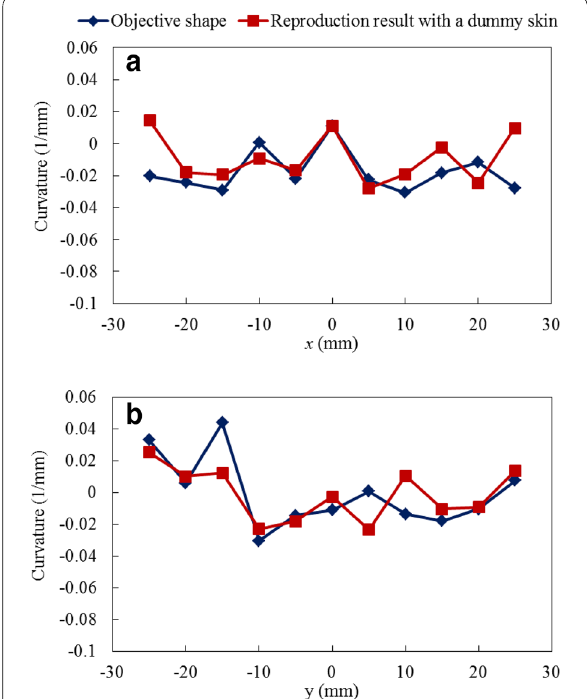
Fig. 9 Curvature comparison results. a Curvature comparison (y b curvature comparison